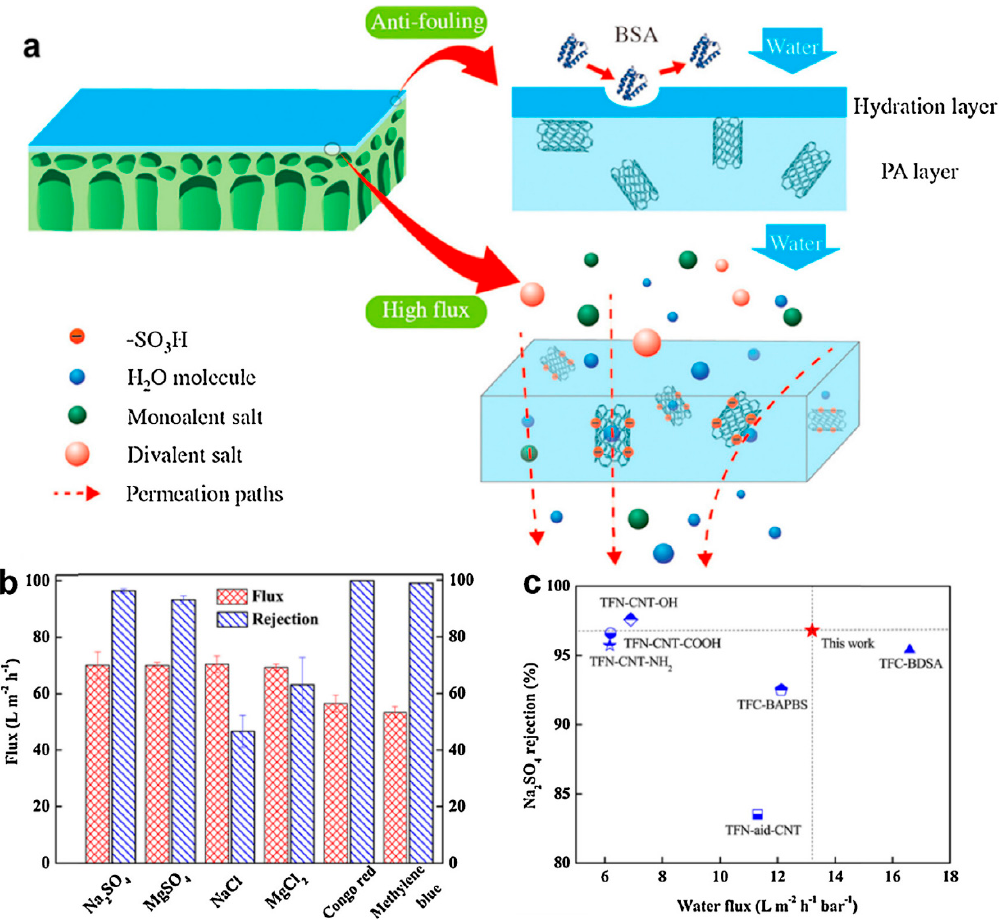
Figure 7. Sulfonated multiwalled carbon nanotube (MWCNT) assisted thin-film nanocomposite (TFN) membrane. ( a ) Representation of the mechanism of membrane separation. ( b ) The separation efficiency of the 0.01% TFN membrane for various salts and dyes at 0.6 MPa and 25 °C. ( c ) Comparing the work results with other sulfonated TFC membranes or the CNT–polymer composite membranes. Reproduced from [109], with permission from Elsevier, 2017.